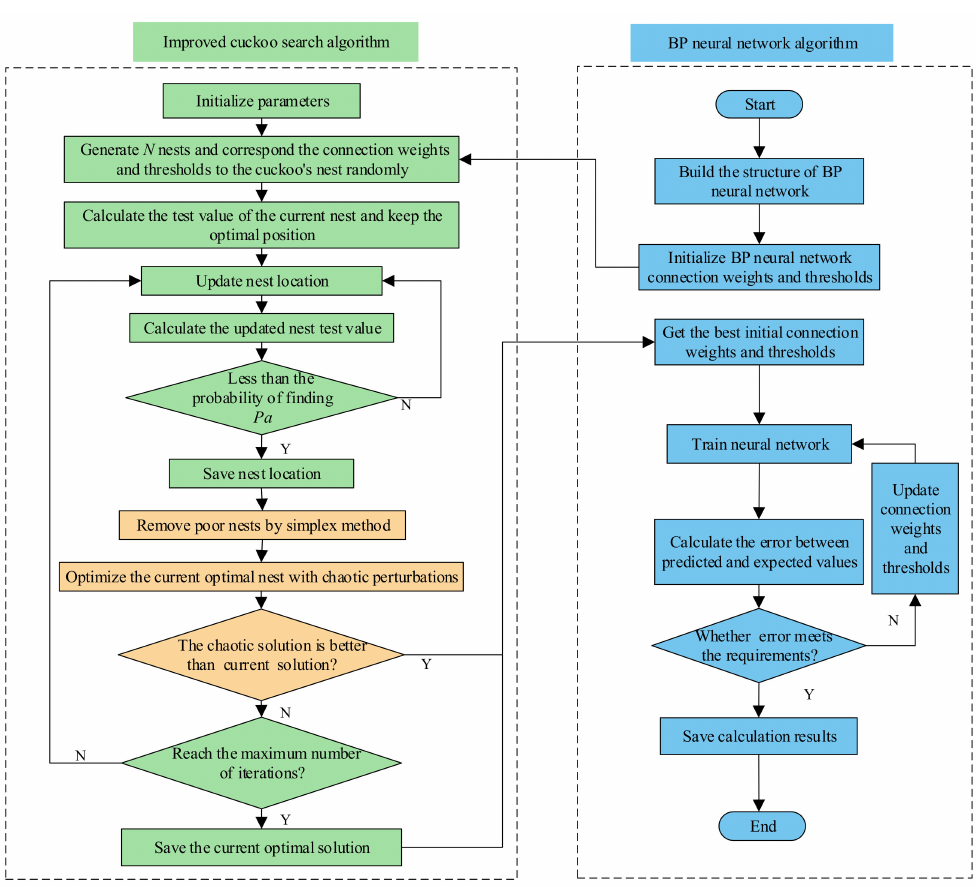
Figure 3. Improved CS-BP algorithm flow chart.